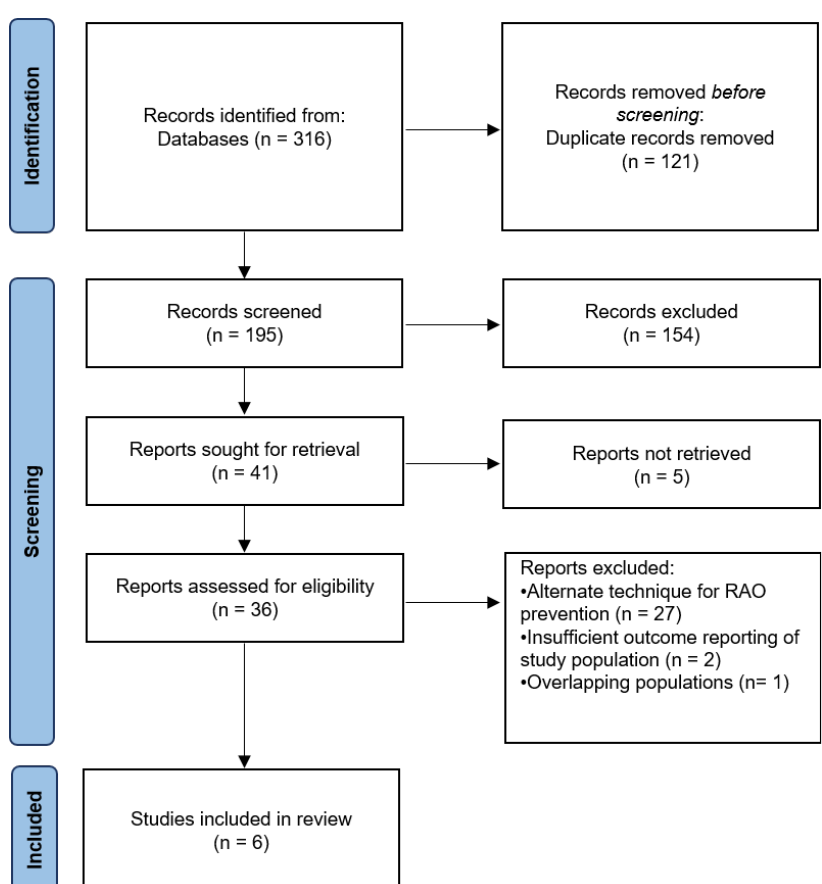
Figure 1. PRISMA flow diagram for search strategy. RAO, Radial artery occlusion.